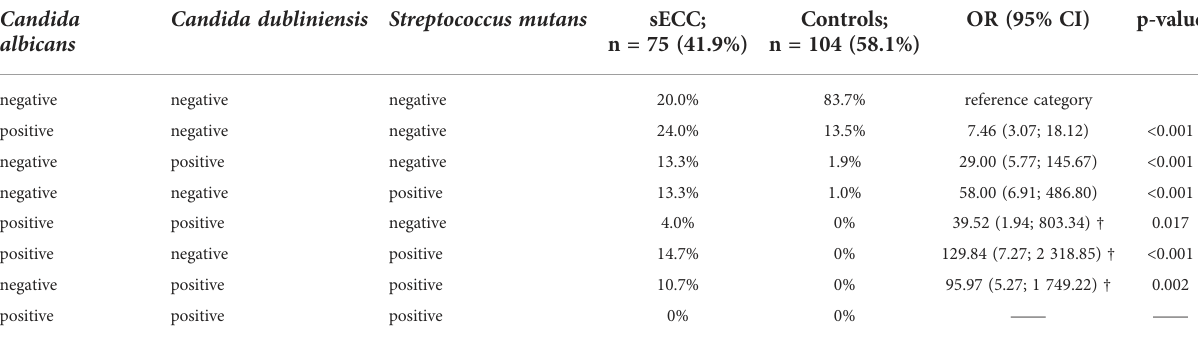
TABLE 3 Association between potential microbial and behavioral risk factors for sECC in univariate and multivariable model based on the entire study group (n = 311).